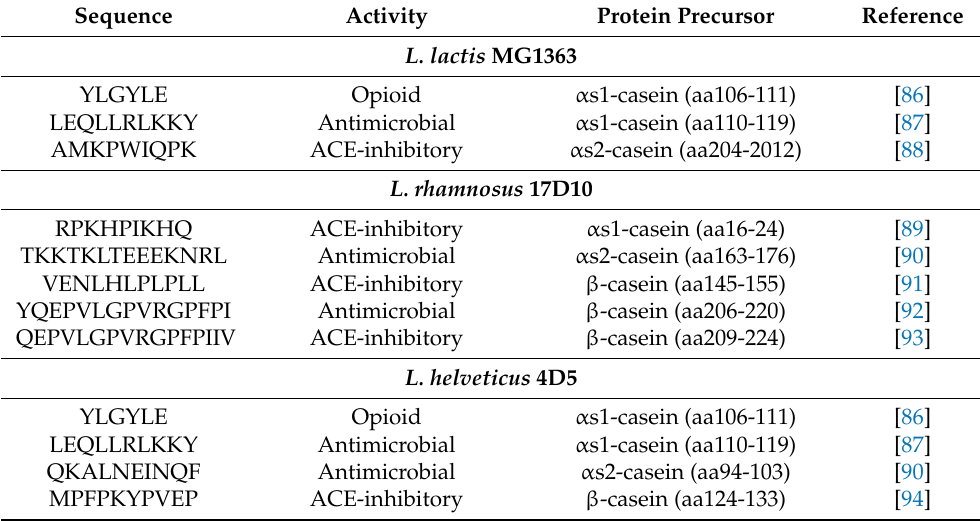
Table 3. List of the identified bioactive peptides released by L. lactis MG1363, L. rhamnosus 17D10 and L. helveticus